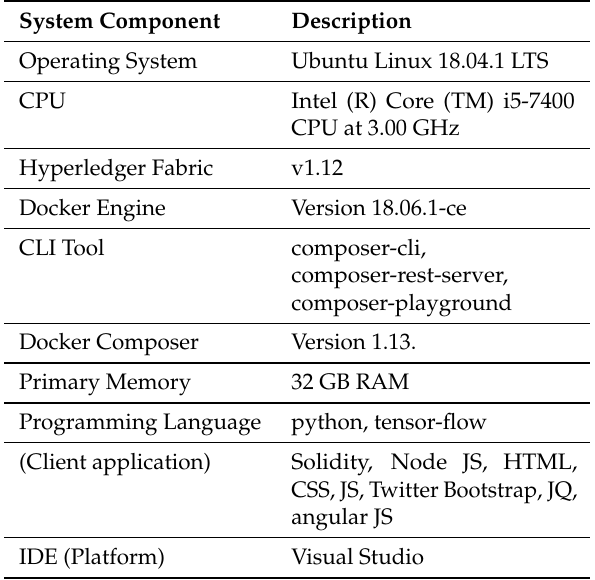
Table 2. Tools and technologies for the implementation of the proposed